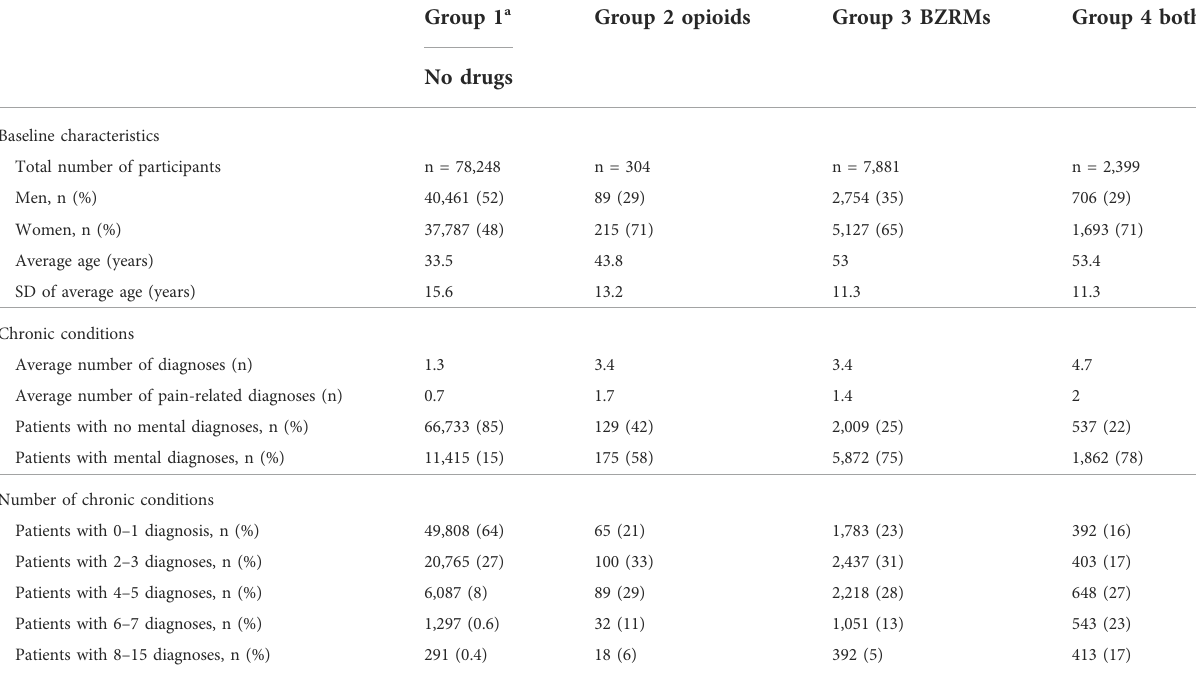
TABLE 2 Comparison of the main baseline characteristics and chronic diseases in the four study groups. In general, the IMR shows that women are prescribed around 80% more of Z-drugs and approximately 110% more of benzodiazepines than